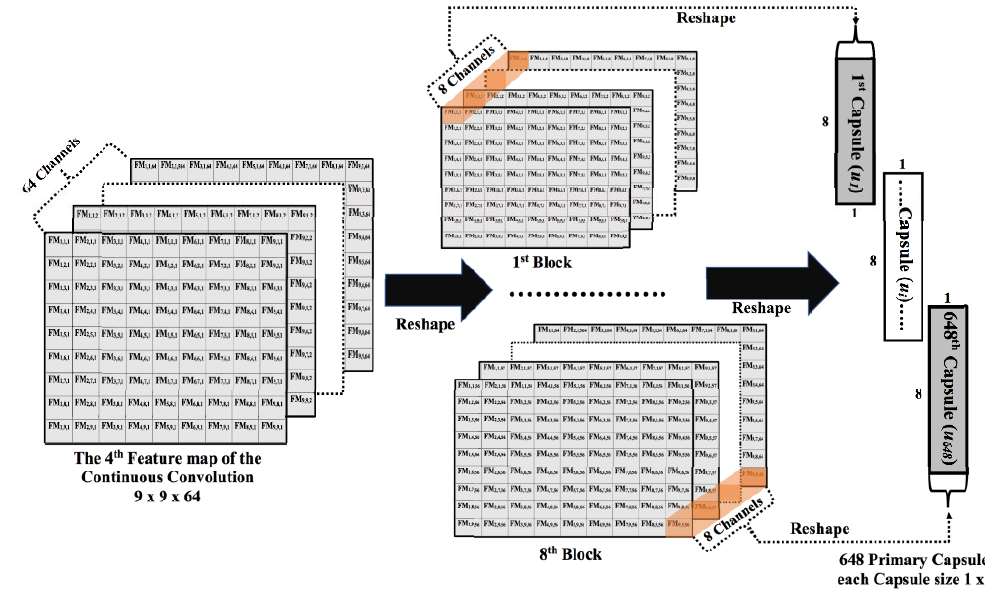
Figure 6. Illustration of the Primary Capsules stage